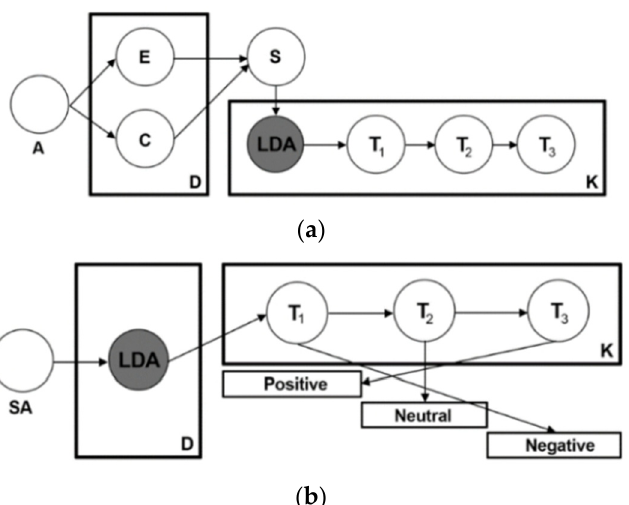
Figure 2. Sentiment Analysis Process from LDA to SA: ( a ) Topics classification process; ( b ) Sentiment Analysis process applied to topics. Source: Adapted from Saura and Bennett [52].